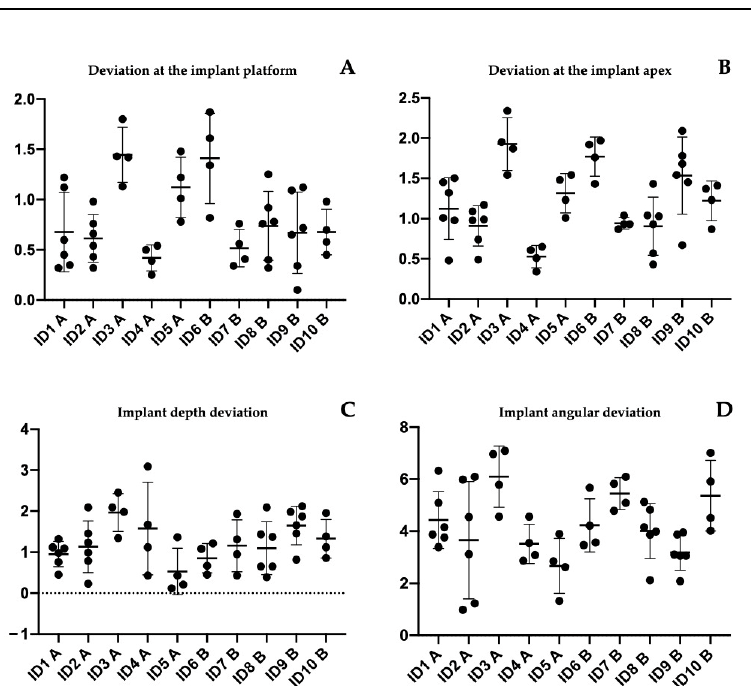
Figure 5. Images of statistical comparisons between the single treated patients. Tukey multiple comparison showed some statistically significant differences between patients. Specifically, as detailed in Table 4, statistically significant differences appeared between maxillary and mandibular rehabilitation. ( A ) Deviation at implant platform among all patients; ( B ) deviation at implant apex among all patients; ( C ) depth deviation among all patients; ( D ) angular deviation among all patients. Table 4. Tukey multiple comparisons between patients. The only significant results are reported here. In all cases, differences emerged between maxillary and mandibula rehabilitation. Mean Diff. 95.00% CI of Diff. Comparisons Test